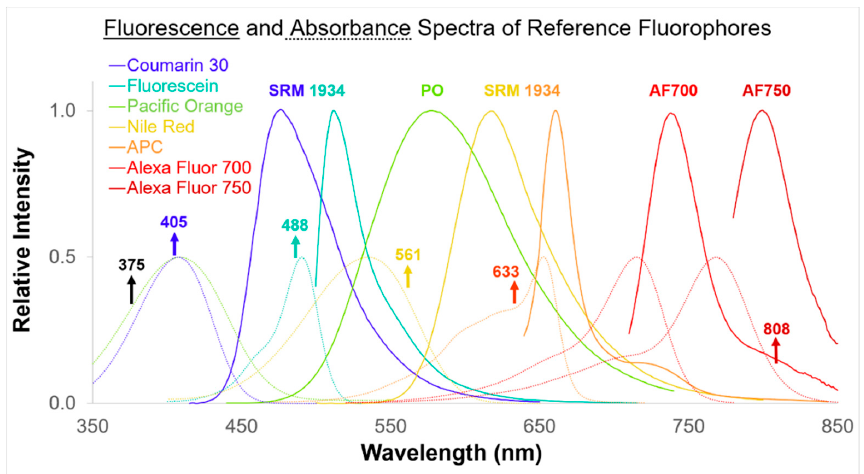
Figure 4. Fluorescence emission (solid lines) and absorbance (dotted lines) spectra of the reference fluorophores used to assign fluorescence intensities in ERF units. The upward arrows show the positions of the excitation lasers for the fluorescence spectrometer.